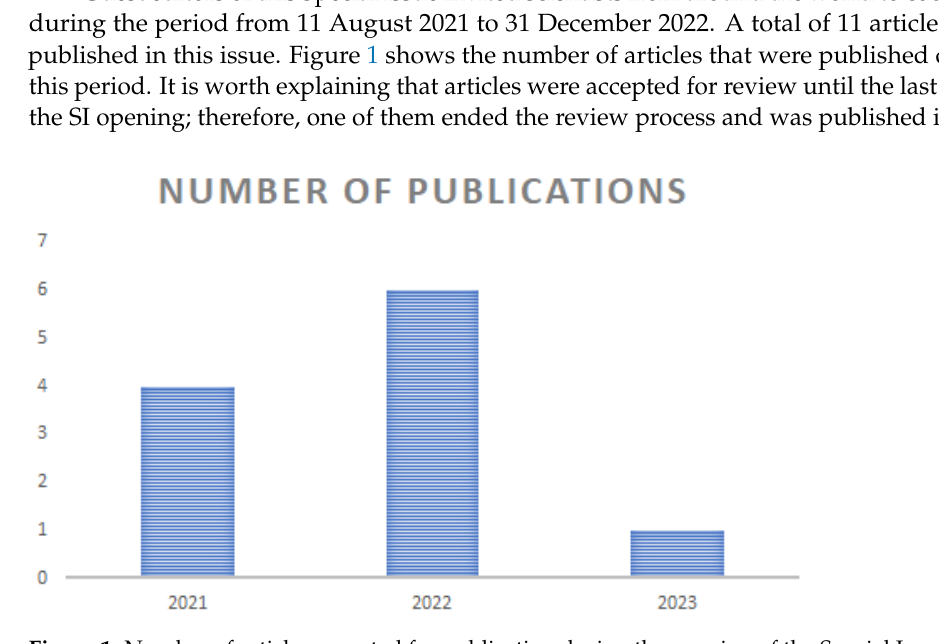
Figure 1. Number of articles accepted for publication during the opening of the Special Issue.